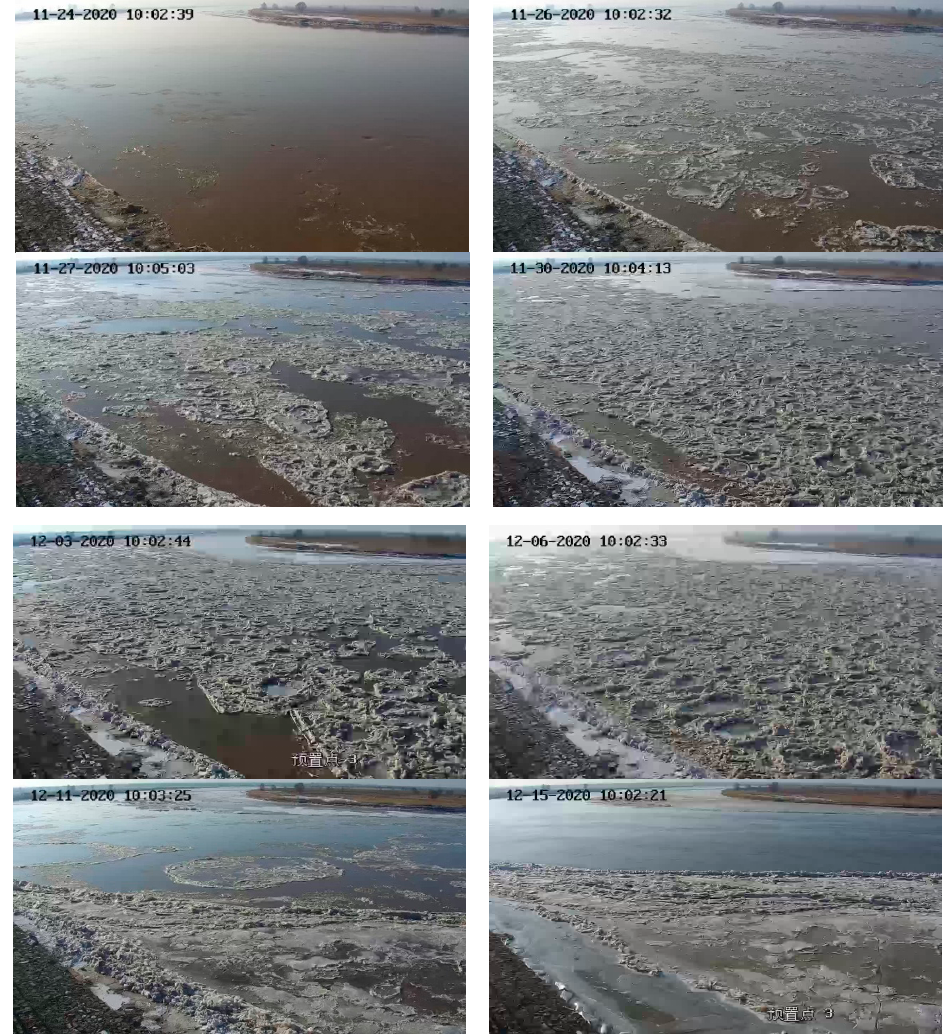
Figure 7. Flow ice scenes on different dates of the 2020–2021 ice period in the Shisifenzi reach.